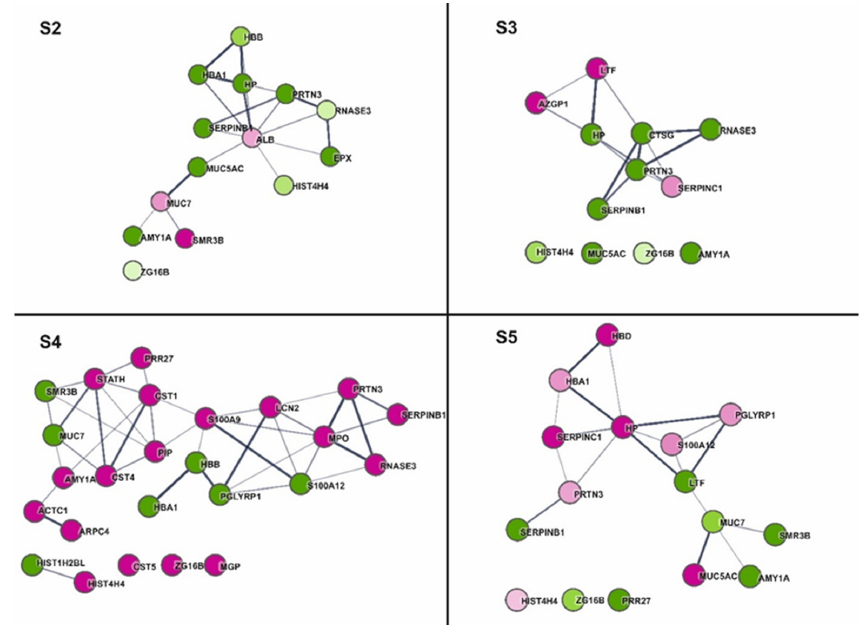
Figure 7. The Cytoscape visualization of STRING-generated network composed of experimentally verified protein − protein interactions among the statistically significant ( p -value < 0.05) quantified proteins for each analysed sample ( S2 – S5 ). The gradation of the fill corresponds to the value of the concentration fold changes. Thus, the darker the fill, the more significant the difference; shades of magenta and green correspond to increased and decreased concentration in the test group, respec- tively.